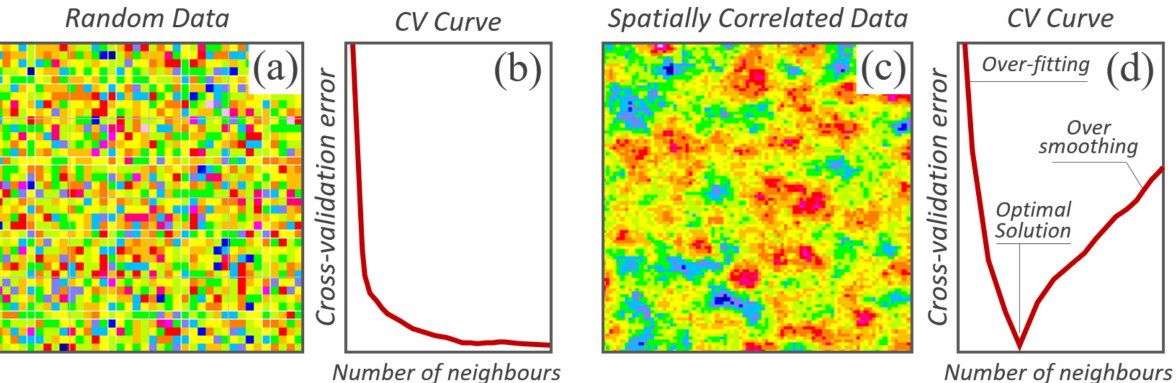
Figure 4. Feature selection with KNN: ( a ) uncorrelated (random) data pattern; ( b ) associated cross- validation error curve steadily declining for uncorrelated data; ( c ) spatially correlated data; ( d ) cross- validation error featuring a distinct minimum for correlated data (after